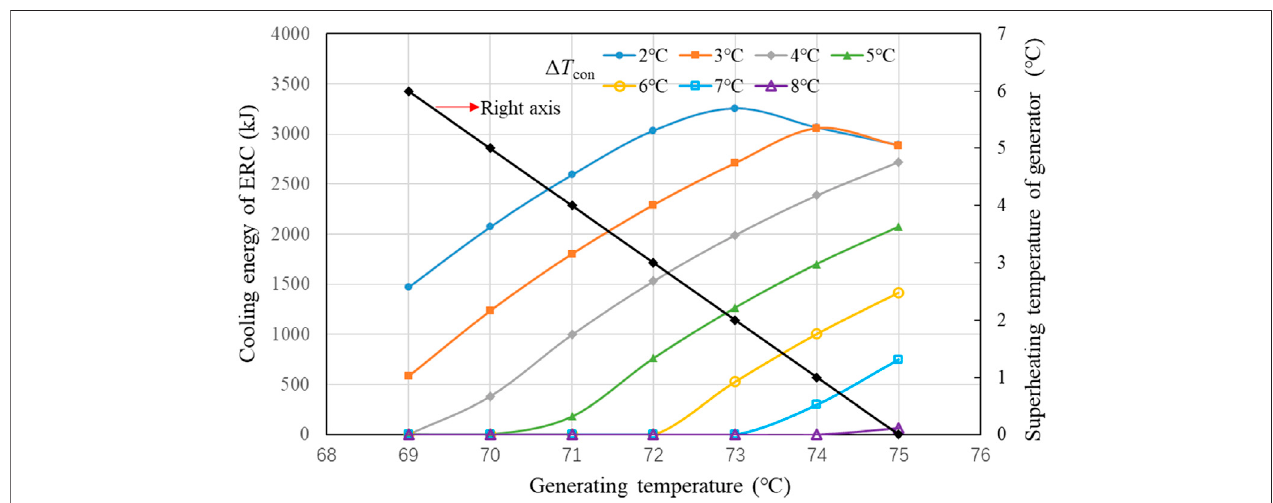
FIGURE 4 | Variation in cooling energy of ERC and superheating temperature of the generator with generating temperature.